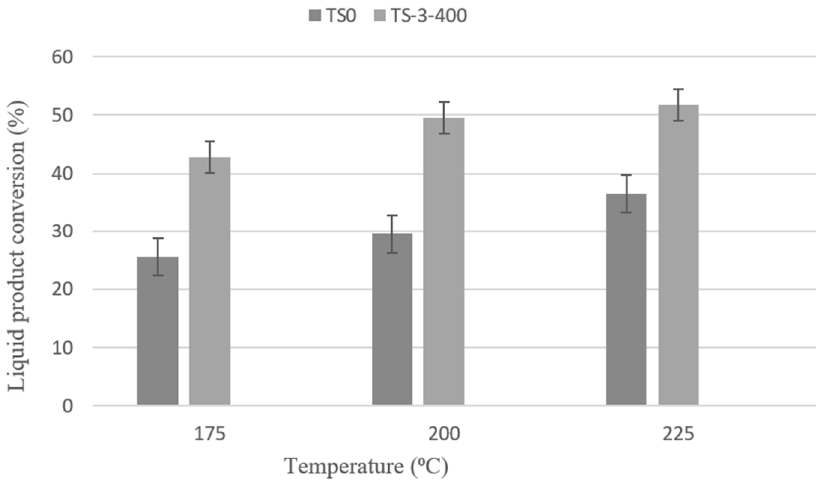
Figure 7. Liquid product conversion of dehydration